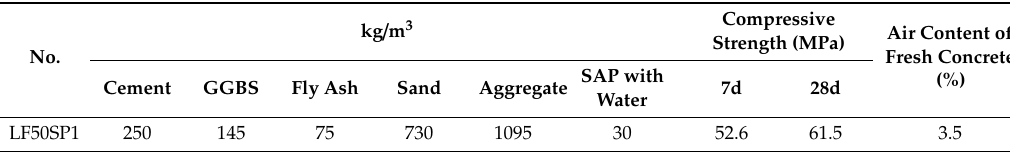
Table 1. Mix proportions of concretes and their properties.